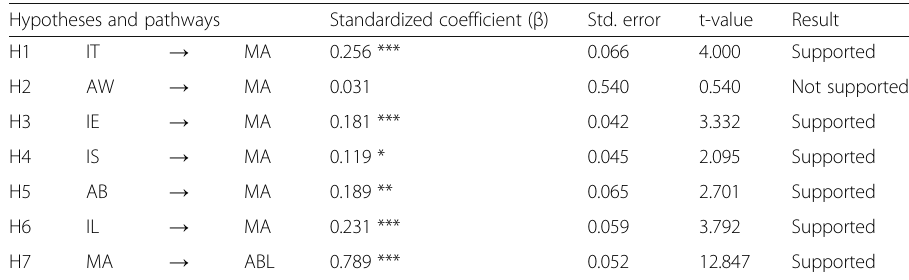
Table 6 Results in Summary Hypotheses and